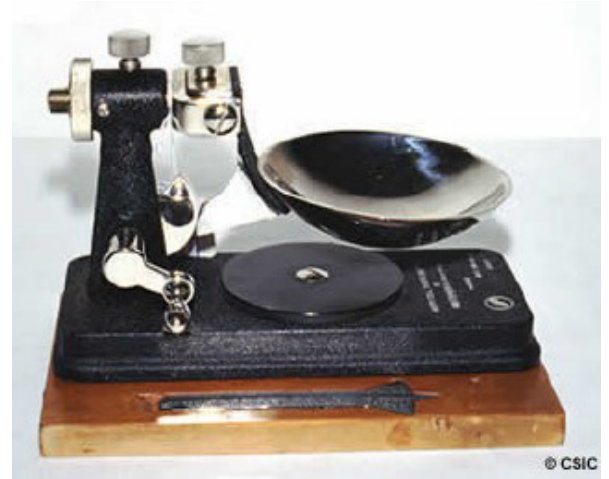
Figure 2. Casagrande bowl (cup), 1942